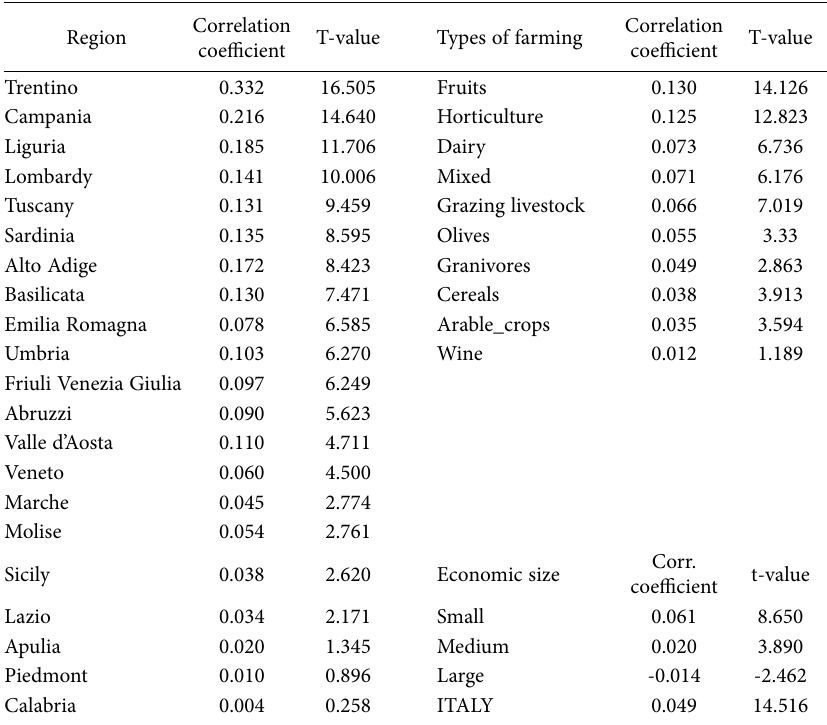
Table 6. Correlation coefficients between the share of immigrants AWU and LP at farm level. Italian FADN sample